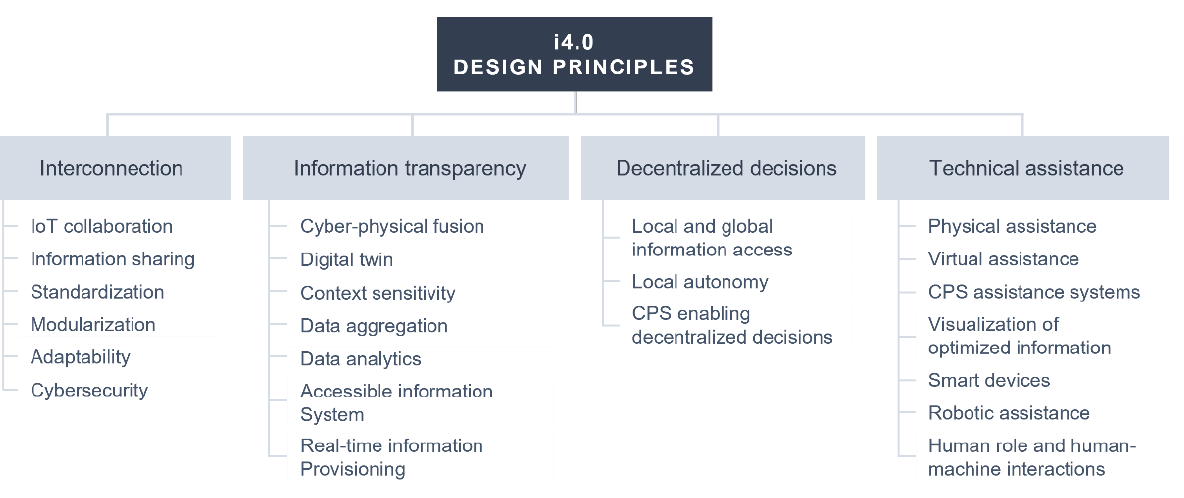
Figure 2. I4.0 design principles, adapted from [36].